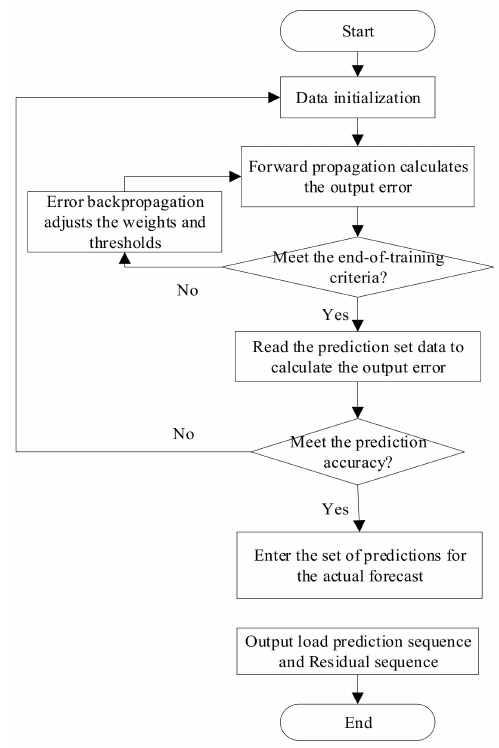
Figure 2. Schematic diagram of the economic dispatch framework for short-term load